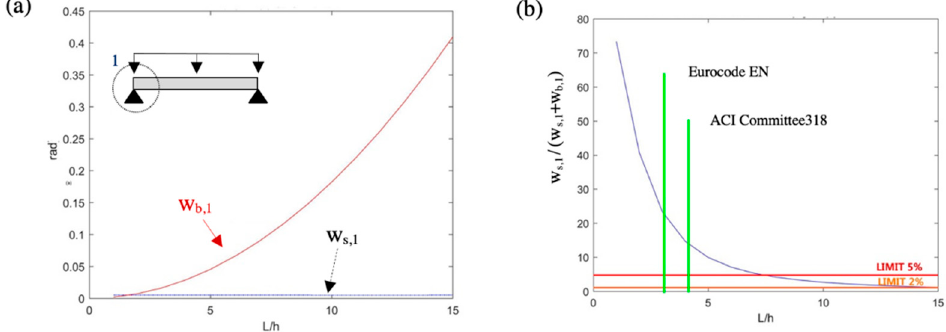
Figure 7. Parametric analysis of the effect of the slenderness ratio on example 2: ( a ) bending ( w b ,1 ) and shear ( w s ,1 ) rotations at node 1 and ( b ) percentage error of rotations in node 1 when w s ,1 was neglected.